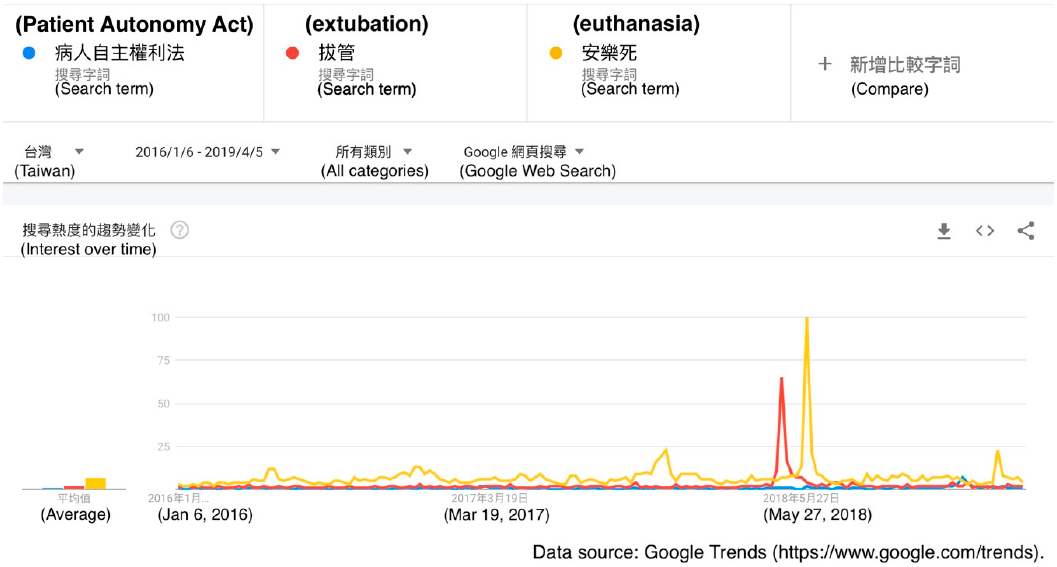
Figure 4. A Google Trends graph for the terms “Patient Autonomy Act” (blue line), “extubation” (red line), and “euthanasia” (yellow line) in Taiwan from 6 January 2016 to 5 April 2019. line), and “euthanasia” (yellow line) in Taiwan from 6 January 2016 to 5 April